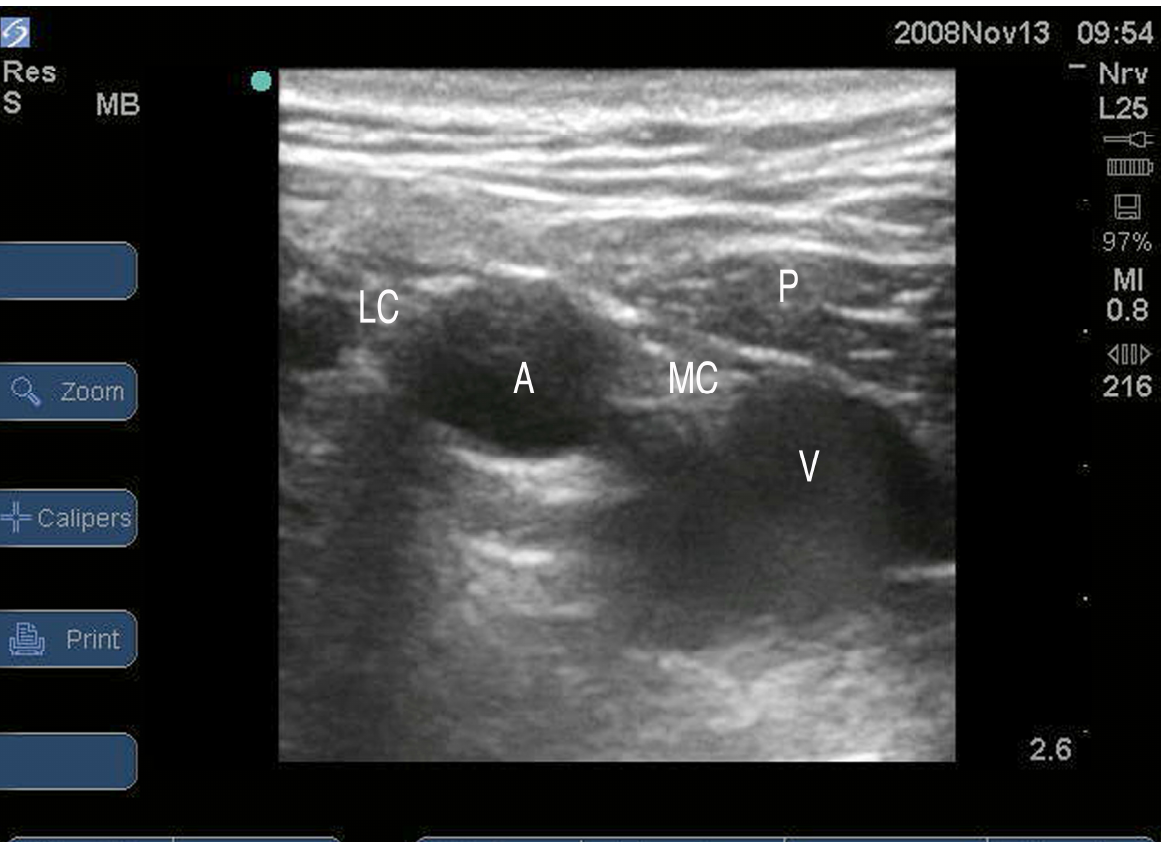
FIGURE 4. Ultrasound image from infraclavicular region, showing the cords of the brachial plexus with the axillary artery and vein. The posterior cord is not well imaged and probably lies directly posterior to the artery. A, axillary artery; V, axillary vein; P, pectoralis minor muscle; LC, lateral cord of brachial plexus; MC, medial cord of brachial plexus.